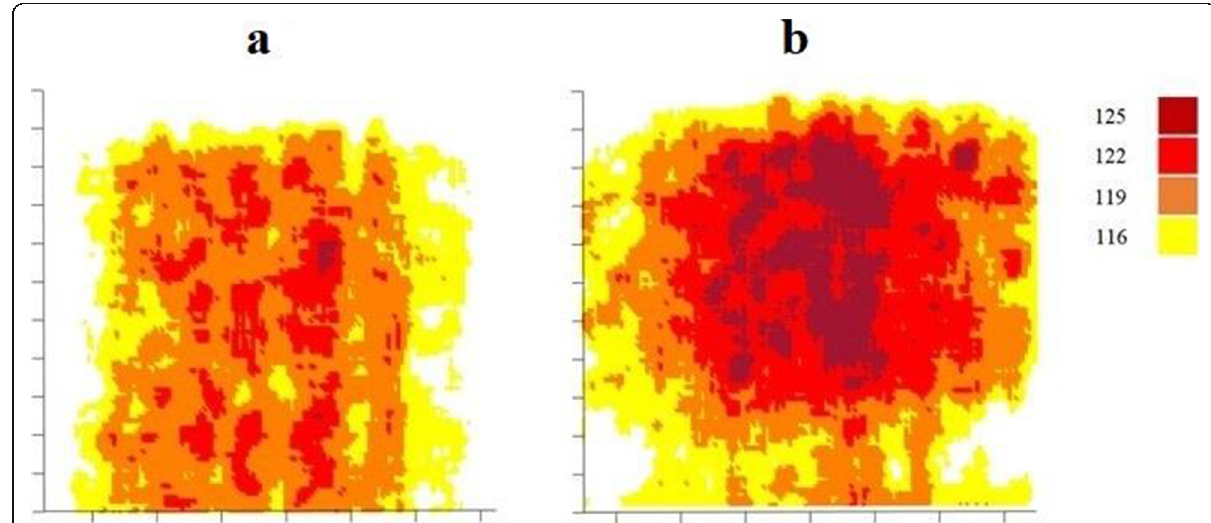
Fig. 5 EBT-3 Measured dose distribution at the concave area that represents the buccal surface. The legend shows a dose percentage relative to dose at isocenter a without and b with an implant. The Y-axis is along the concaveness and the X-axis is along the row of